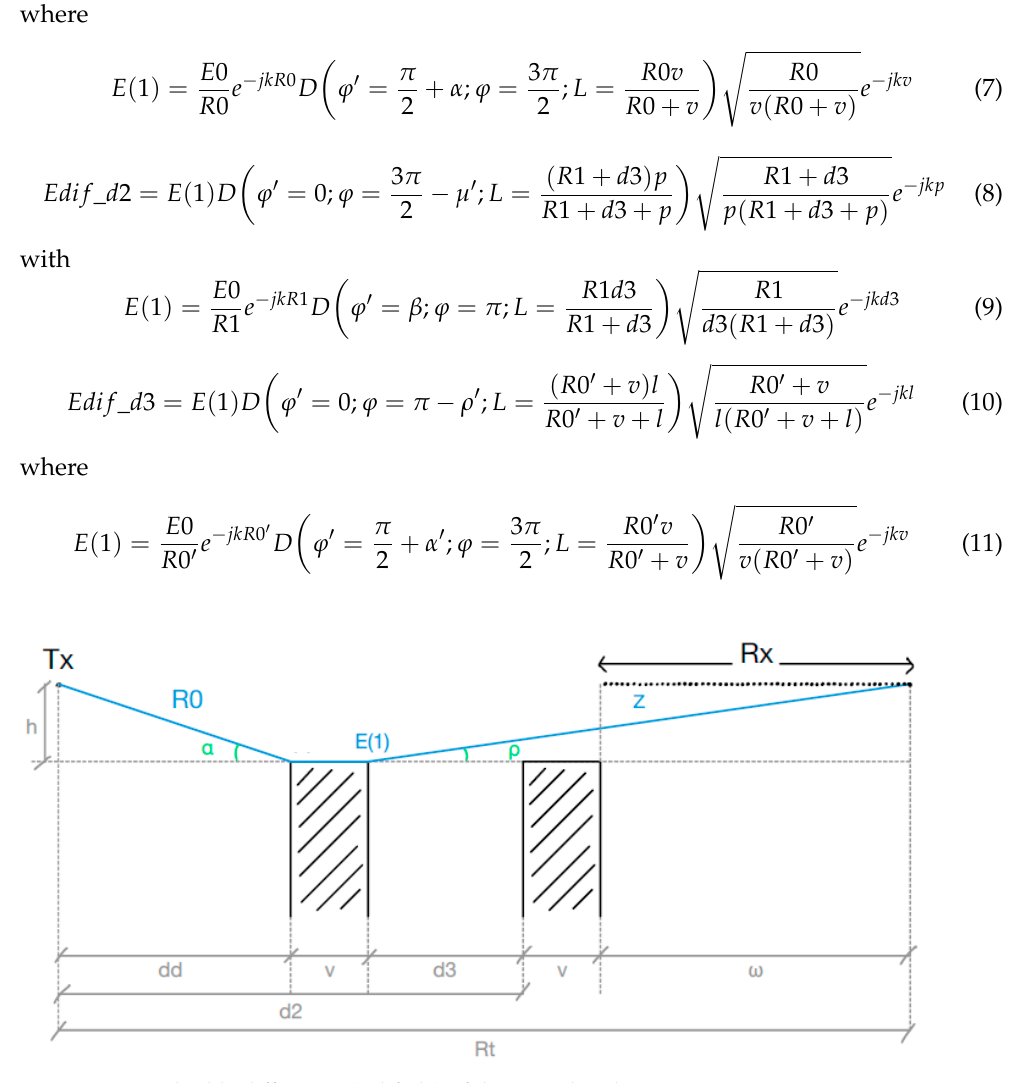
Figure 7. First double diffraction (Edif_d1) of the considered LOS scenario.